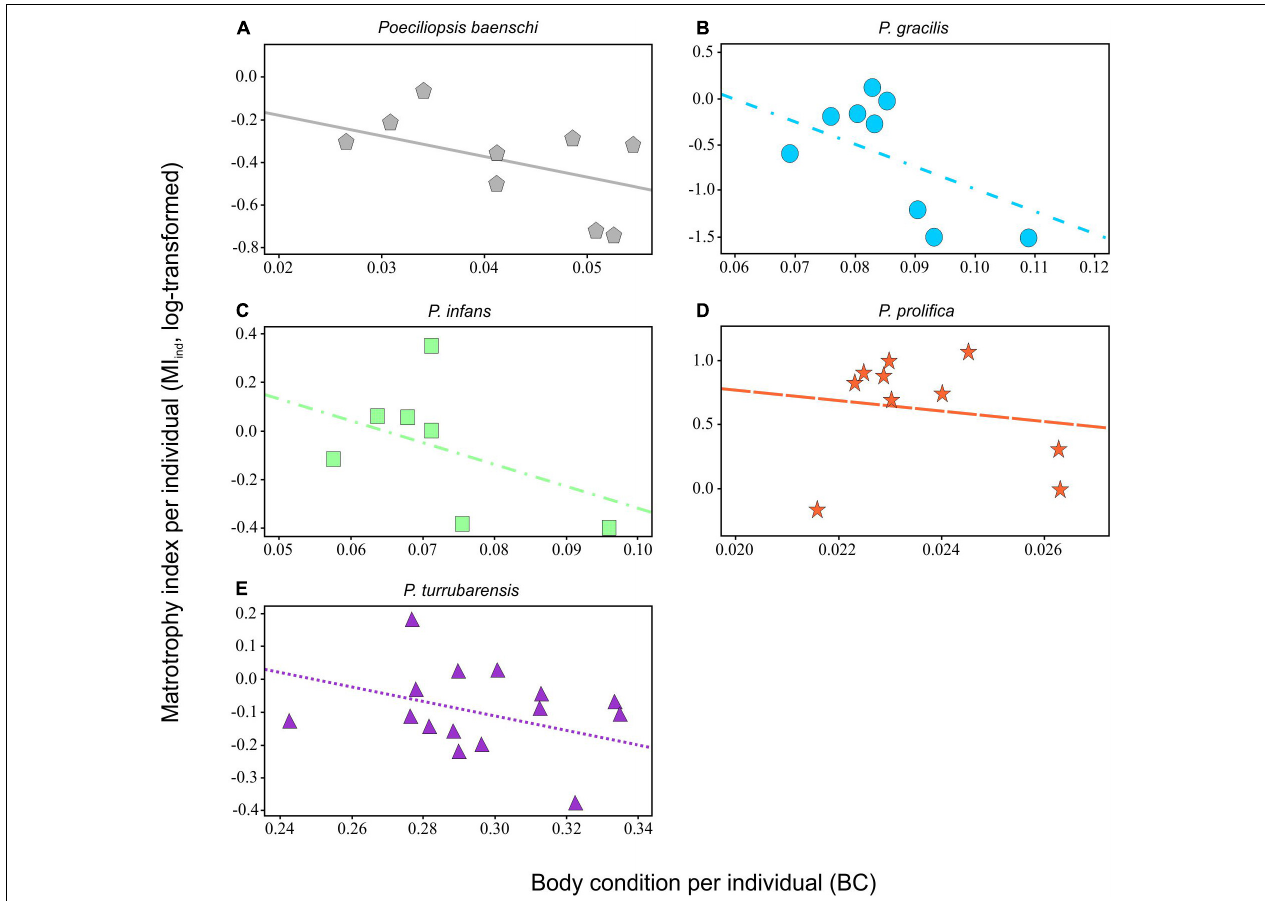
FIGURE 5 | Negative association between the MI ind and individual BC for 51 females of five fish species from the genus Poeciliopsis . Each species is shown in a different panel because of substantial differences among species in the values of BC. Fitted lines represent model-averaged regression coefficients. Each symbol represents a different species as per ( Figures 1 , 2